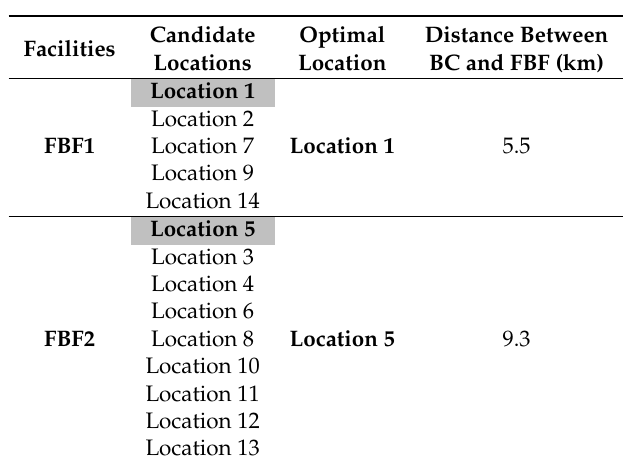
Table 4. Candidate and optimal locations of the fixed blood facilities.